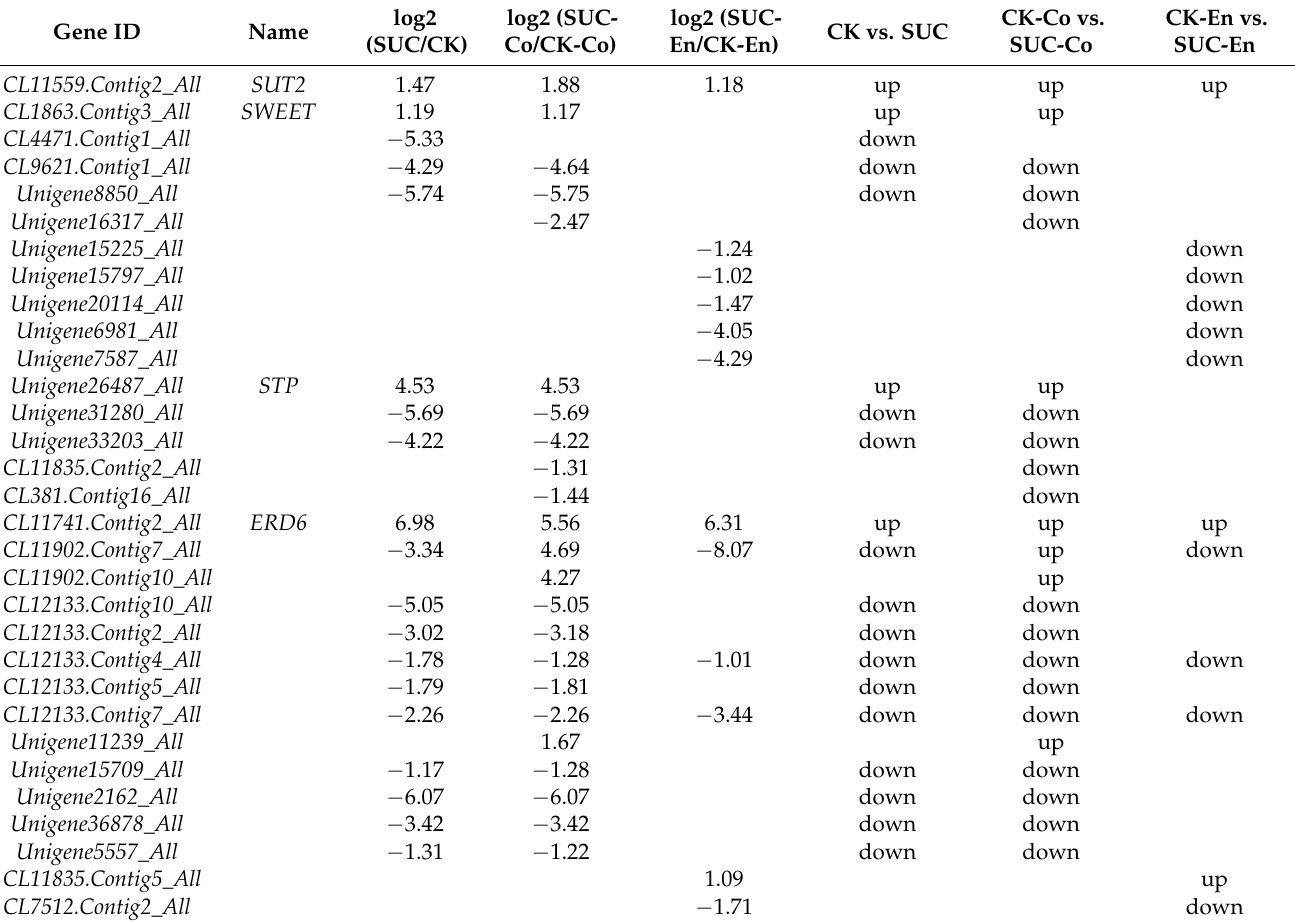
Table 1. Analysis of main DEGs related to sucrose metabolism and transporter in P. ostii